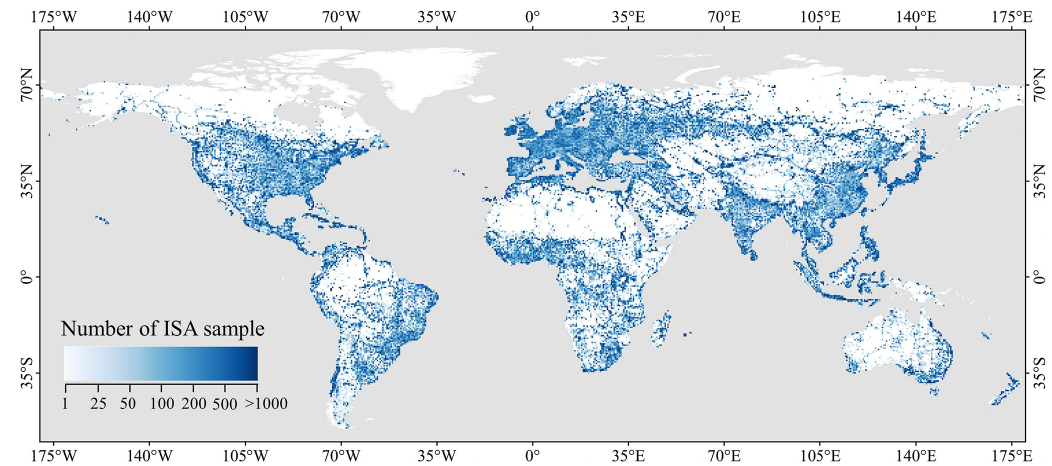
Figure 4. Global distribution of ISA training samples. The number of samples was counted within 0.5 ◦ spatial